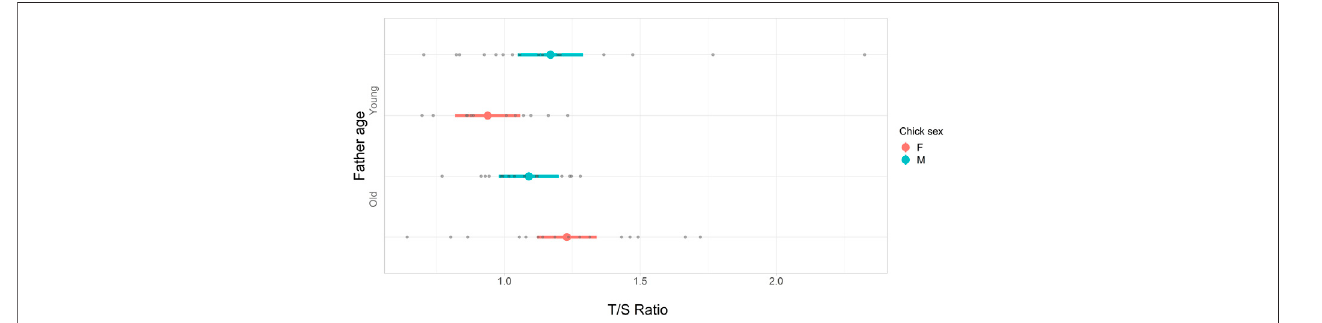
FIGURE 2 | Forest plot of the posterior modes (red and blue dots) and corresponding 95% credible intervals (lines) from a linear mixed-effects model testing the relationship between T/S 3 , father age, and sex of chicks ( Table 2 ). Fathers were assigned an age category of young, “ Y ” , or old, “ O ” . A young father hatched in the preceding summer, and an old father was > 4 years old. Chick sex is indicated as either female, “ red ” , or male, “ blue ” . The number of offspring in each category; Y, and female = 12, male = 16, O, and female = 16, male = 15. Raw data points are shown as grey dots.